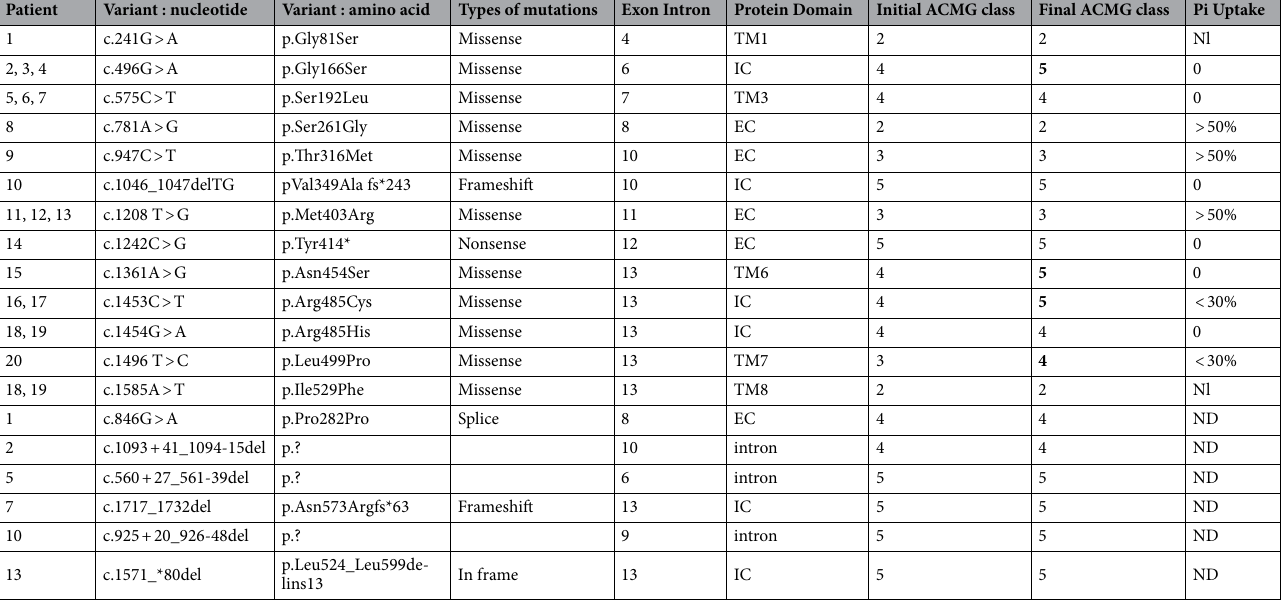
Table 3. Genetic characteristics of SLC34A3 variants. ACMG American College of Medical Genetics, TM transmembrane, EC extracellular, IC intracellular, Nl normal, ND not defined. Initial ACMG